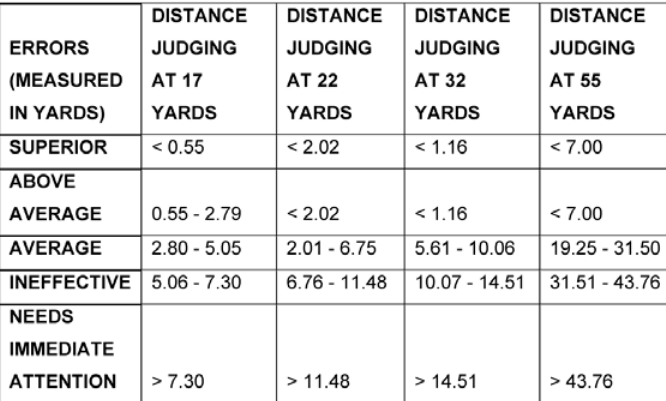
Table 7: The norms for distance judging at 17, 22, 32 and 55 yards are